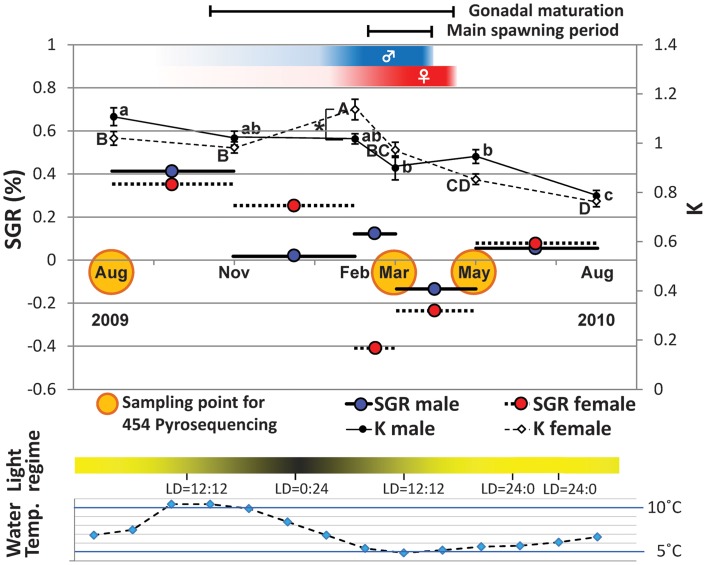
Growth history of Atlantic cod throughout their first reproductive cycle.At the start of the experiment the fish were two years old (males, n = 49; females, n = 84). Specific growth rate SGR (%) is indicated by horizontal line (males) and dotted line (females). Somatic condition factor (K) is displayed by black dots (males) and white diamonds (females). The bar underneath indicate the light regime corresponding to the natural environmental photoperiod conditions in Bodø (67°N), Norway. Sea water temperature is represented by blue diamonds with a dashed line. Asterisks (*) indicates significant differences between sexes at a particular sampling point at P < 0.05 (two-tailed t-test). Different superscript letters highlight significant differences within the same sex throughout the reproductive cycle at P < 0.05 (Tukey's multiple comparison test; lower-case letters: males; capital letters: females). Sampling points of fast skeletal muscle for 454 pyrosequencing are indicated by yellow circles.